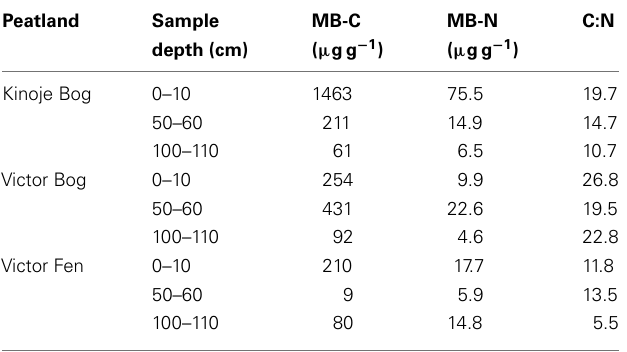
Table 1 | Microbial biomass C and N within peat soil at three depths from cores collected from three James Bay peatlands ( n = 1).